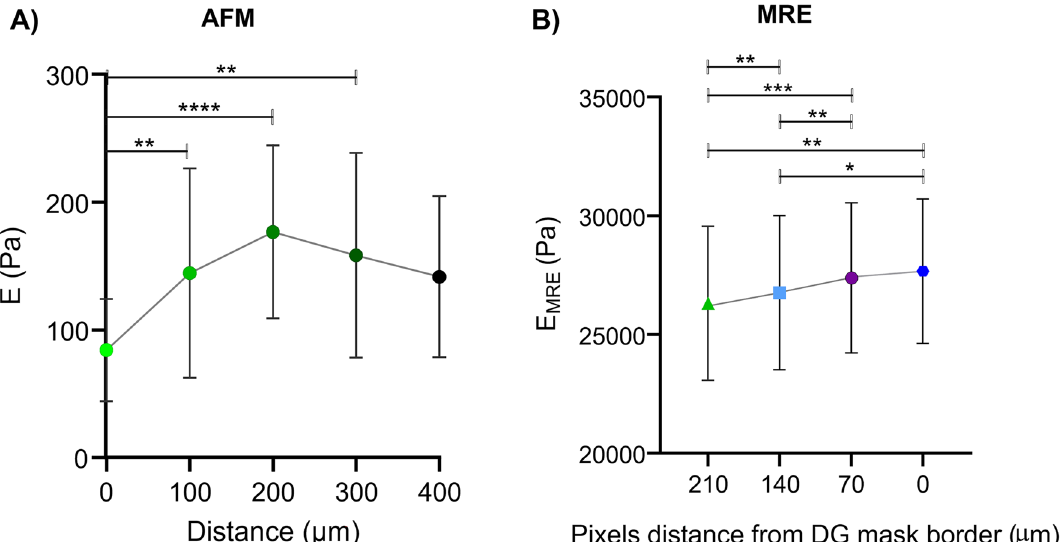
Figure 6. Comparison of ex vivo AFM and in vivo MRE results. ( A ) Stiffness increases with greater distance (in µm) from the peak of the fluorescence signal (marked as 0), 0 µm vs. 100 µm **p = 0.0025; 0 µm vs. 200 µm ****p < 0.0001; 0 µm vs. 300 µm **p = 0.0069, 0 µm n = 15, 100 µm n = 15, 200 µm n = 15, 300 µm n = 10, 400 µm n = 5. ( B ) Similar results are seen in vivo when the dentate gyrus mask is eroded: original mask (0 µm) vs. 2 pixel eroded mask (140 µm), *p = 0.0309, eroded original mask (0 µm) vs. 3 pixels eroded mask (210 µm), **p = 0.0043; 1 pixel eroded (70 µm) vs. 2 pixel eroded mask (140 µm), **p = 0.0051; 1 pixel eroded (70 µm) vs. 3 pixel eroded mask (210 µm), ***p = 0.0005; 2 pixel eroded (140 µm) vs. 3 pixel eroded mask (210 µm), **p = 0.0069), n =